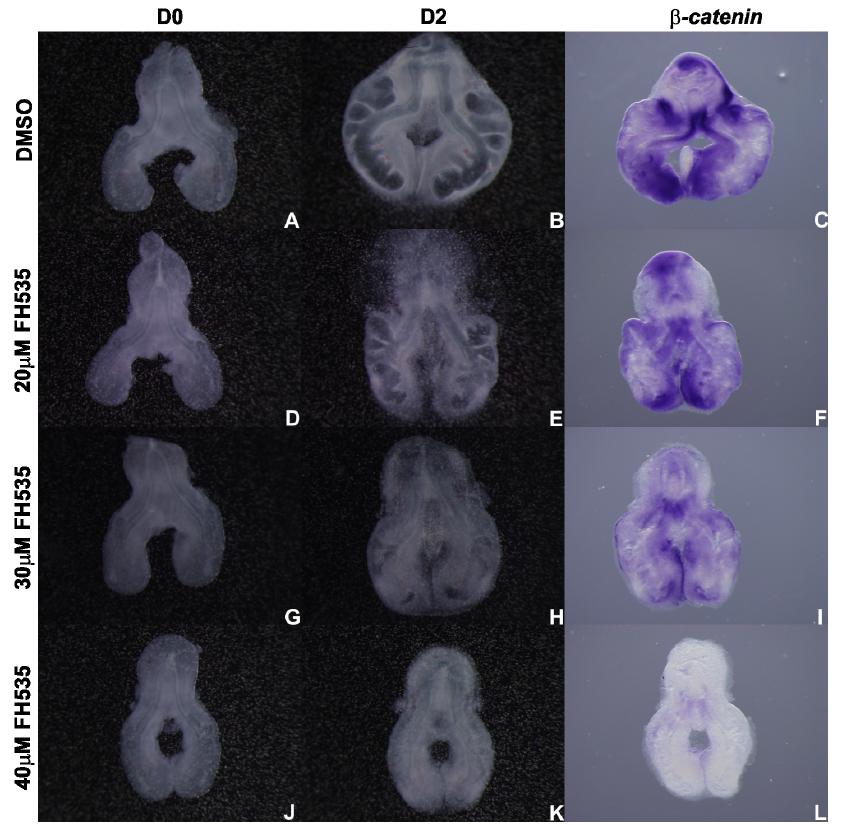
Figure 7. In vitro Wnt signaling inhibition (FH535) and b -catenin expression. Representative examples of stage b2 lung explant culture, at D0:0h (A, D, G, J) and D2:48h (B, E, H, K) treated with DMSO (A, B), 20 m M (D, E), 30 m M (G, H) and 40 m M FH535 (J, K) and probed with b -catenin (C, F, I, L); n 5 5 for each stage. Magnification: A, B, D, E, G, H, J, K –4x; C, F, I, L –5x.